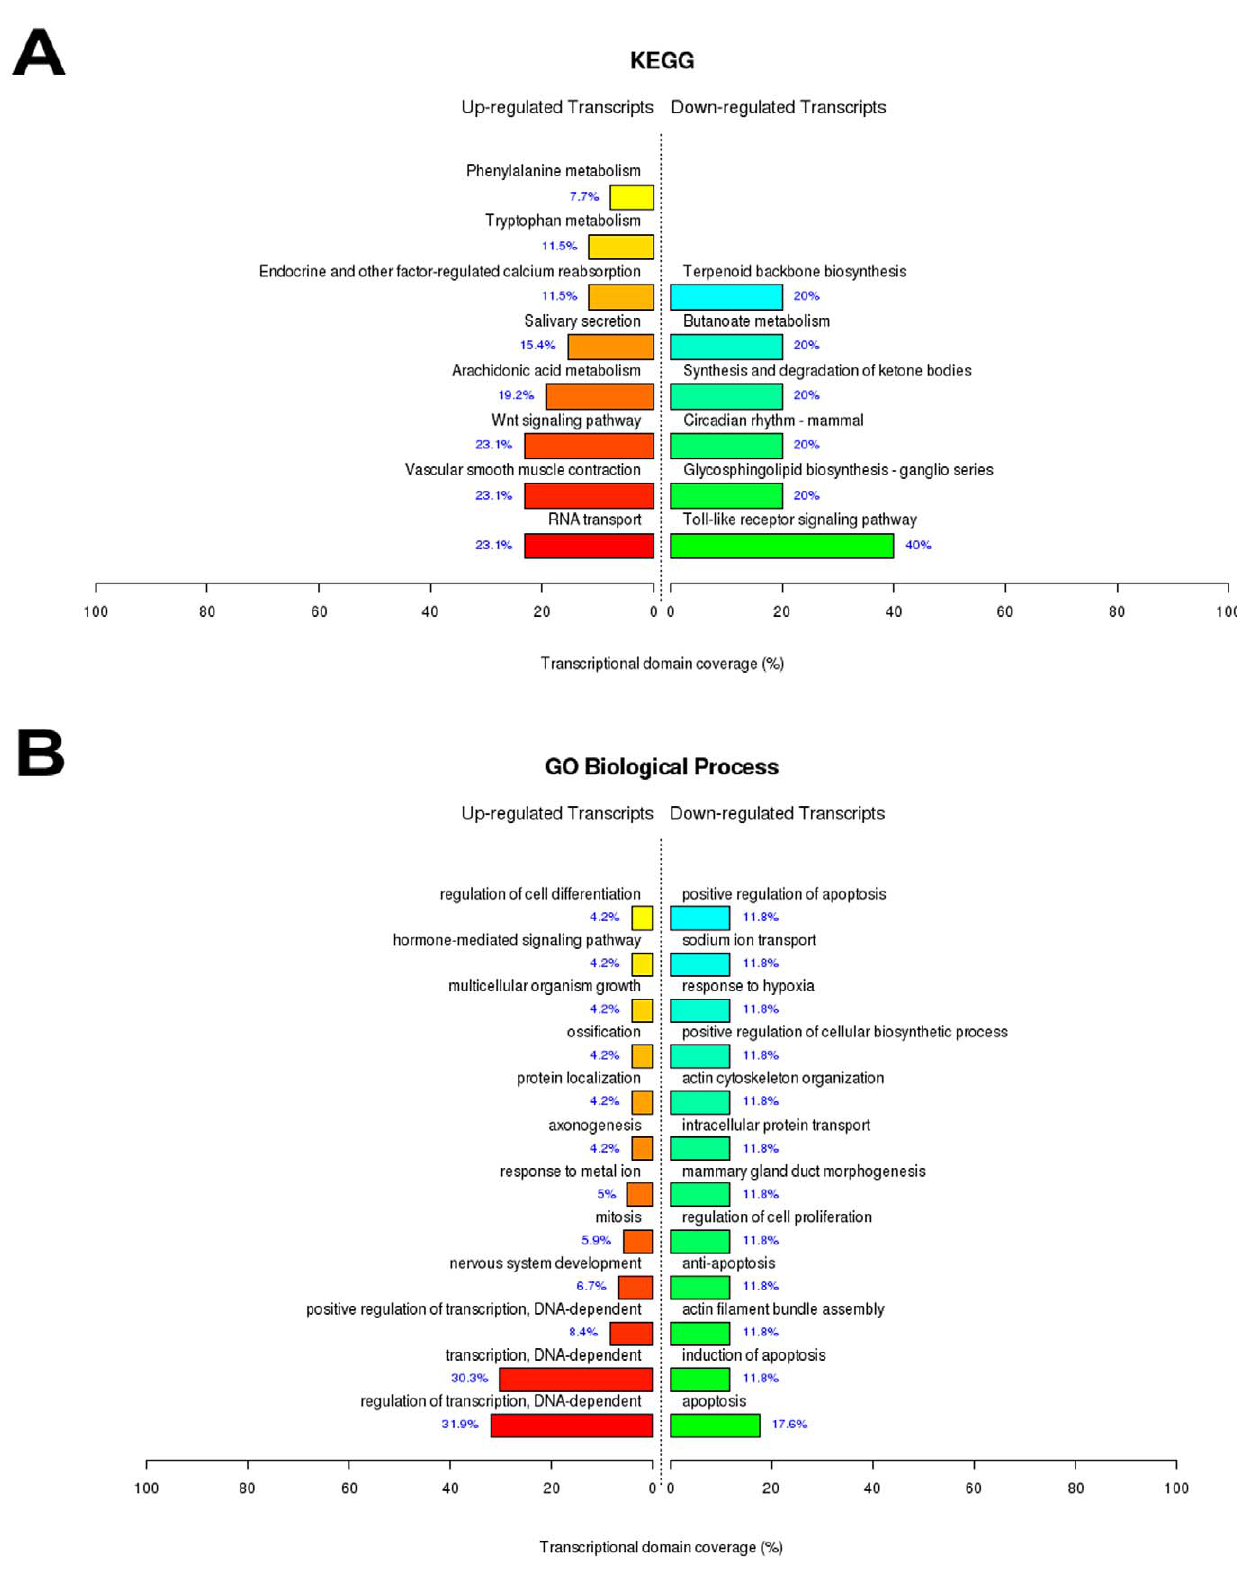
Figure 5. Top ranked biological functions after renal ischemia/reperfusion injury in mice that received previous hemin treatment. A) KEGG categories showing significant enriched functions for differentially expressed genes at IRI + Hemin vs IRI comparison; B) Biological Process Ontology (GO) of the differentially expressed genes at IRI + Hemin vs IRI comparison. The bar plot represents the percentage of genes differentially expressed and functionally annotated in isolated kidney tissue. Bar plot colors represent up (red) and down (green) regulated genes.